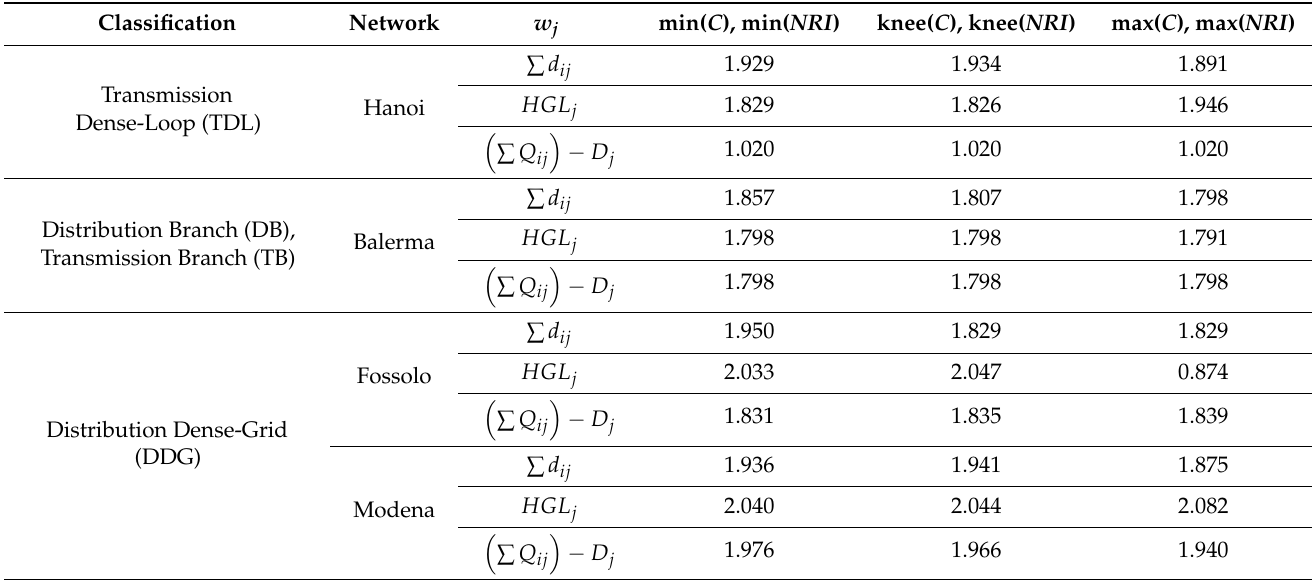
Table 5. Fractal dimension ( D ) for the revised criteria w j